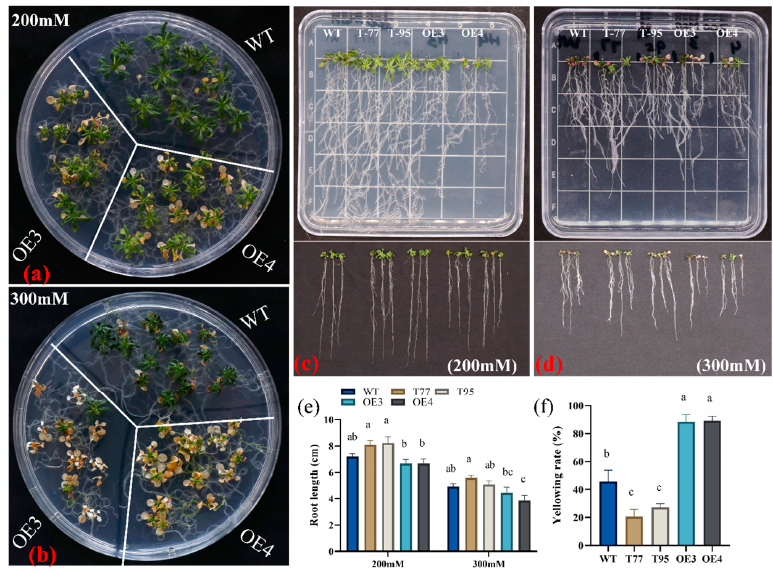
Figure 5. Comparison of drought-stress responses of overexpressing TrHSFB2a lines and RNA interference T-DNA lines and wild type grown on 1/2MS medium (with 3% sucrose + 0.7% agar) supplemented with 200 or 300 mM mannitol. ( a , b ) Display overexpression TrHSFB2a Arabidopsis thaliana along with wild type grown on 1/2MS medium supplemented with 200 and 300 mM mannitol, respectively, ( c , d ) show plant with roots growth on 1/2MS medium supplemented with 200 and 300 mM mannitol, respectively. ( e ) Root length on 1/2MS medium supplemented with 200 and 300 mM mannitol, respectively. ( f ) Plant-yellowing rate on 1/2MS medium supplemented with 200 mM mannitol. Bars represent mean ± SD values, and different small letters (a, b, and c) represent significant statistical difference among means (one-way ANOVA, followed by Tukey test) between different lines.